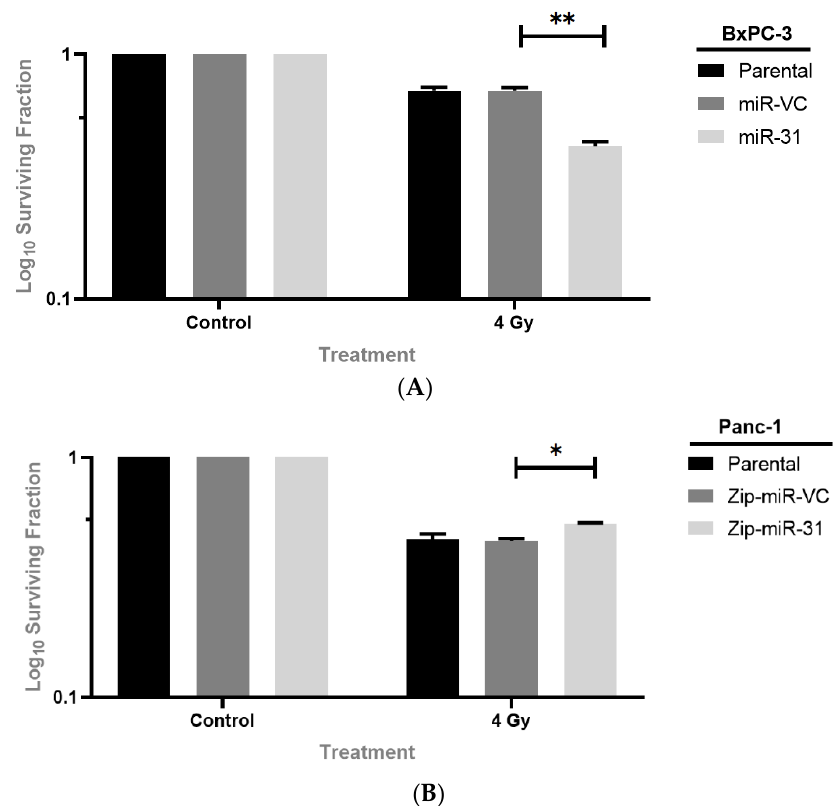
Figure 3. Manipulating miR-31 regulates radiosensitivity in PDAC cell lines. ( A ) Overexpressing miR-31 in BxPC-3 cells significantly reduced surviving fraction (** p = 0.00891) post-irradiation. ( B ) Suppressing miR-31 in Panc-1 cells showed a significant increase in survival fraction (* p = 0.0211). All cells were irradiated with 4 Gy, while controls were mock-irradiated (0 Gy) 24 h post-seeding. Data are expressed as the mean ± SEM and analyzed by a two-tailed paired t -test ( n = 3).